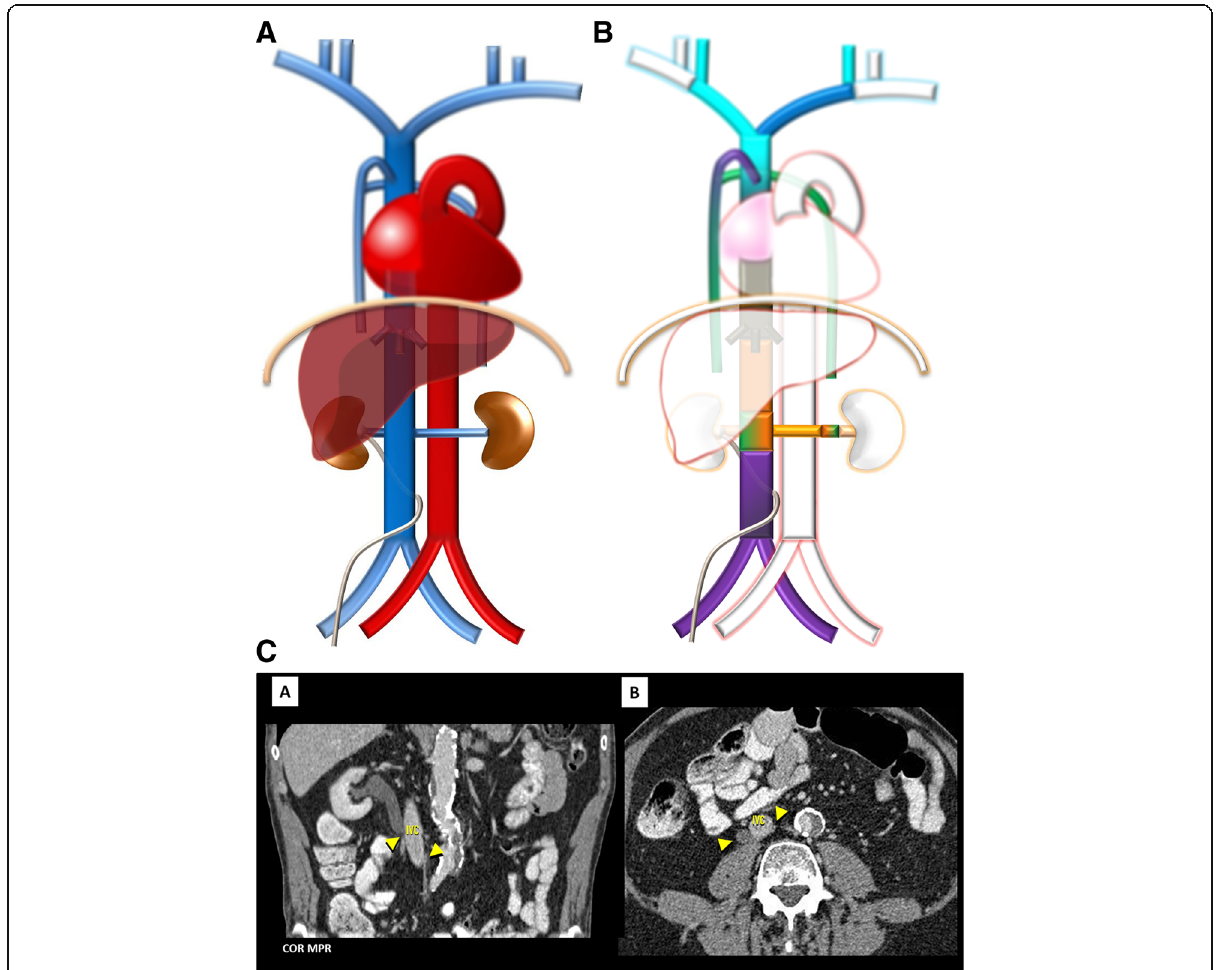
Fig. 12 a Circumcaval ureter schematic. An anomaly as the name implies, in which the ureter begins to course dorsal to the IVC, then arches the IVC to come to lie ventrally. b Circumcaval ureter embryology schematic. Resulting from the persistence of the right posterior cardinal vein positioned ventral to ureter in the definitive IVC. c Circumcaval ureter imaging. Contrast-enhanced CT presentation of a circumcaval ureter, which begins to course dorsal to the IVC, then arches the IVC by the left, coming to lie anteriorly, associated with mild proximal